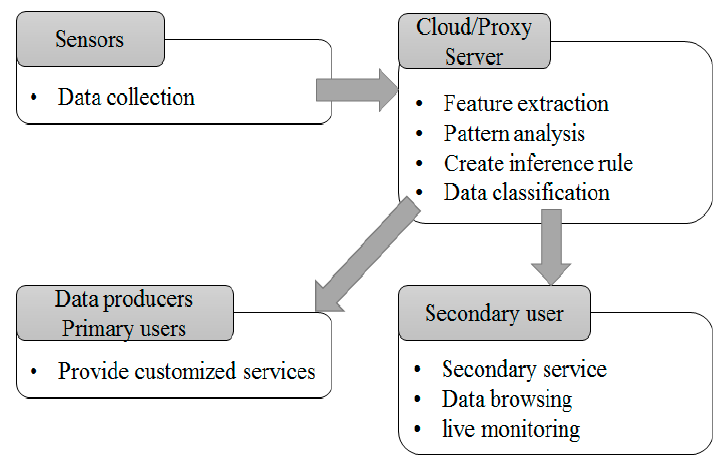
Figure 1. Data flow according to access authority.